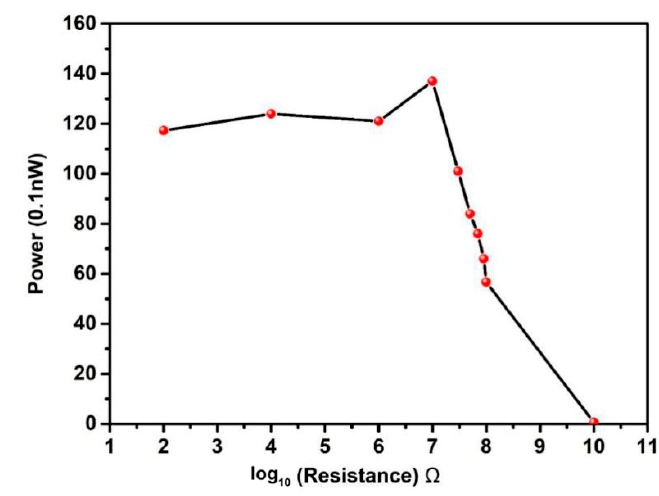
Figure 11. The relationship between resistance and power output. The optimized resistance is found Ω . It is so large because of the simulated structure’s scale is on the micron scale. to be around 10 7